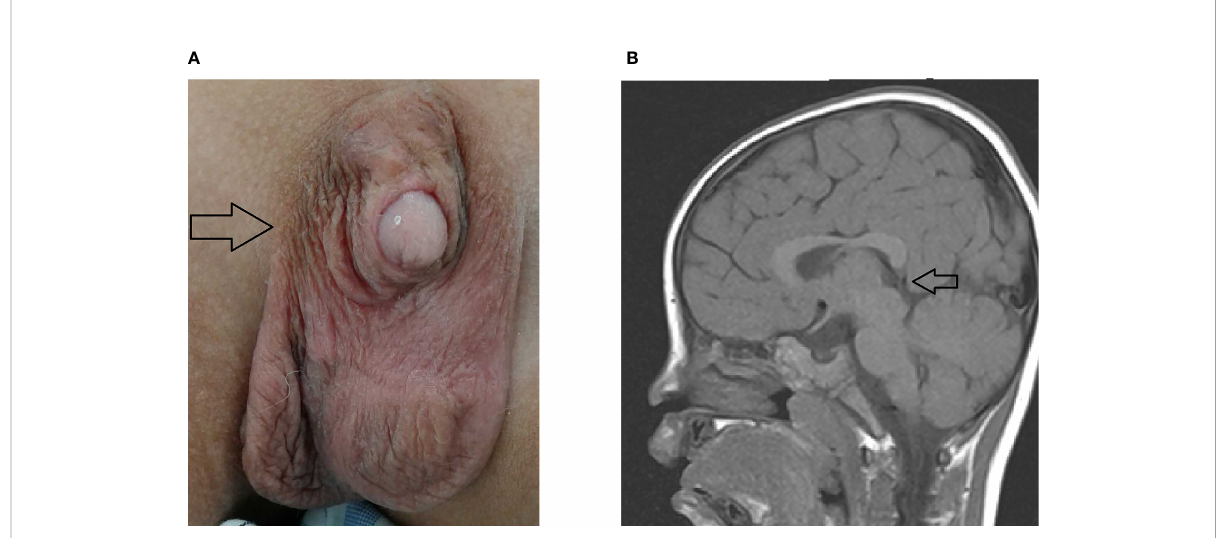
FIGURE 2 Patient 4 with hypocalcemic seizures that started 6 days after birth, had facial dysmorphism and hearing impairments. The patient ’ s calcium level was 6.0 mg/dL (ion calcium, 0.63 mg/dL). (A) He had ambiguous genitalia (arrow), scrotal bi fi da with hypospadias, penoscrotal transposition, congenital heart disease with double outlet right ventricle, ventricular septal defect, atrial septal defect, and pulmonary stenosis. Chromosome study con fi rmed the ring chromosome 9 and Kleefstra syndrome. (B) His MRI exhibited hypoplasia of splenium part of corpus callosum